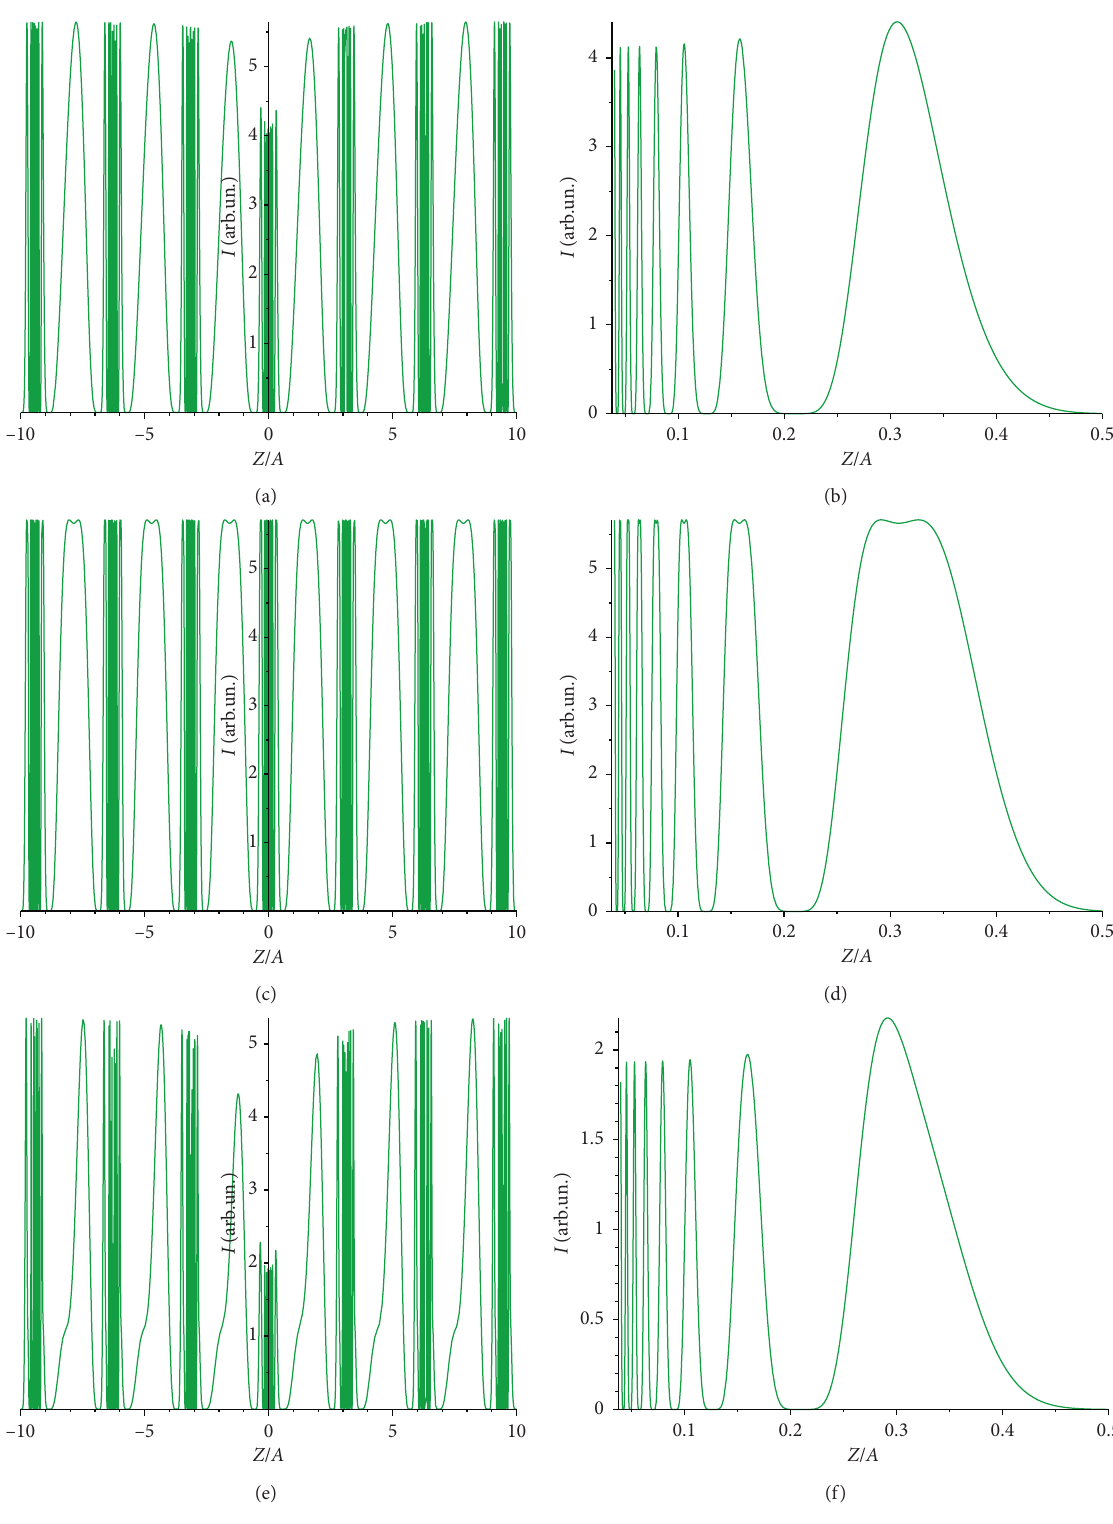
Figure 2: Optical intensity resulting from a plane wave diffraction by a circular aperture using spherical harmonics for n ≤ 1. (a, b) Optical intensity resulting along the optical axis for Z � ( 135 × 10 − 4 ) m. (c, d) Optical intensity resulting in the geometrical focal plane for Z � ( 115 × 10 − 4 ) m. (e, f) Optical intensity resulting along the boundary of the geometrical shadow for Z � ( 197 × 10 − 4 )